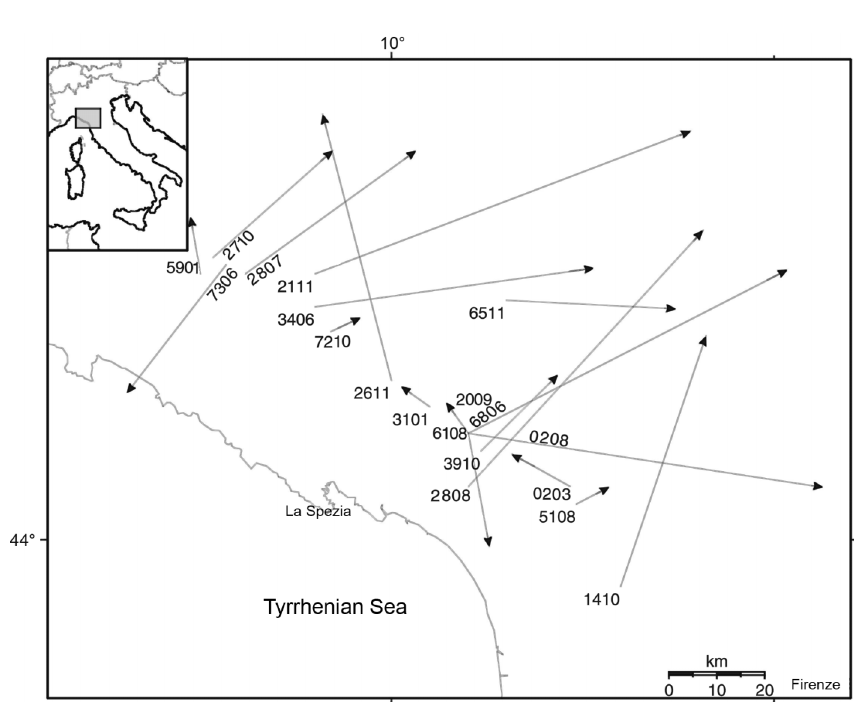
Fig. 4. Vectors connecting the original macroseismic location with the instrumental one as obtained in this